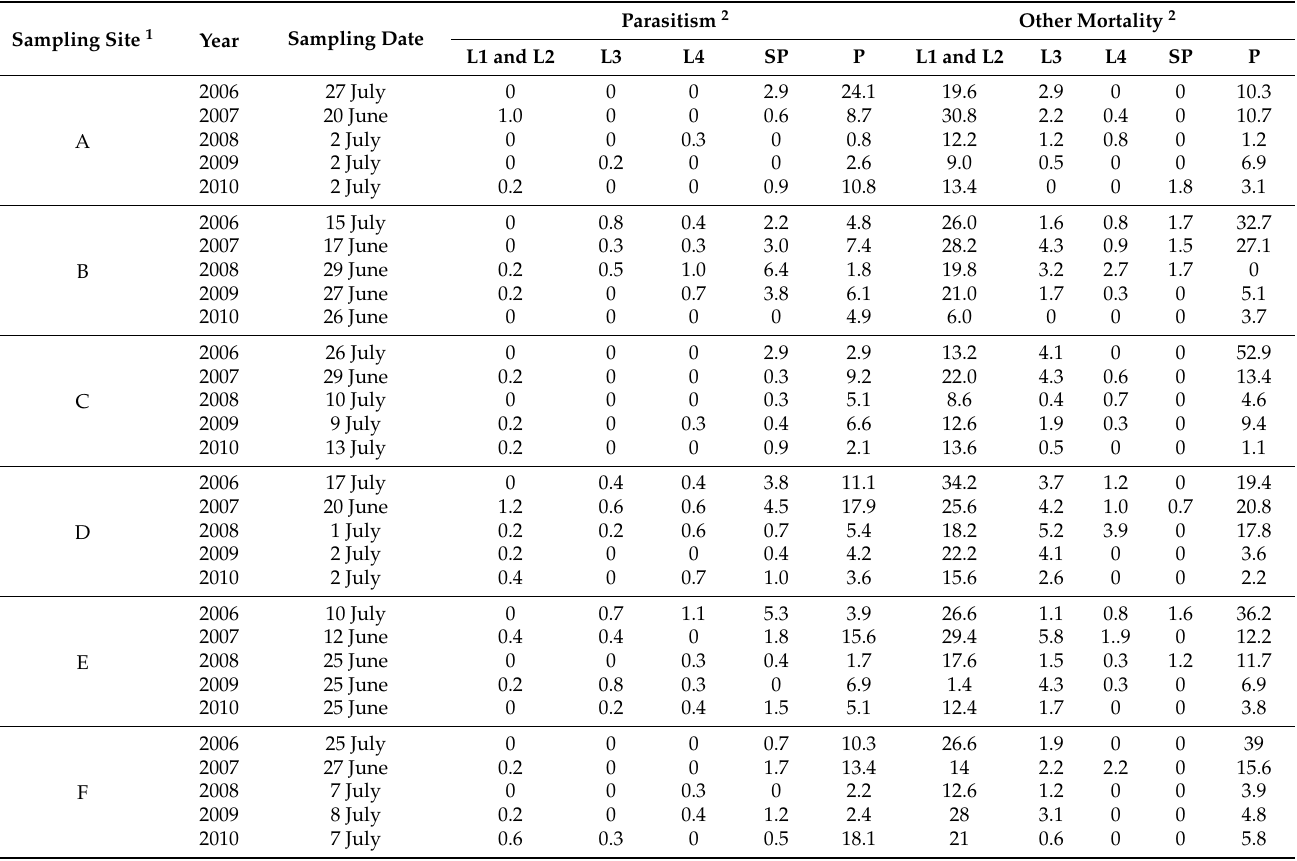
Table A1. Parasitism and other mortality rates (%) on the different developmental stages of C. ohridella at six sites in the Czech Republic from 2006 to 2010.